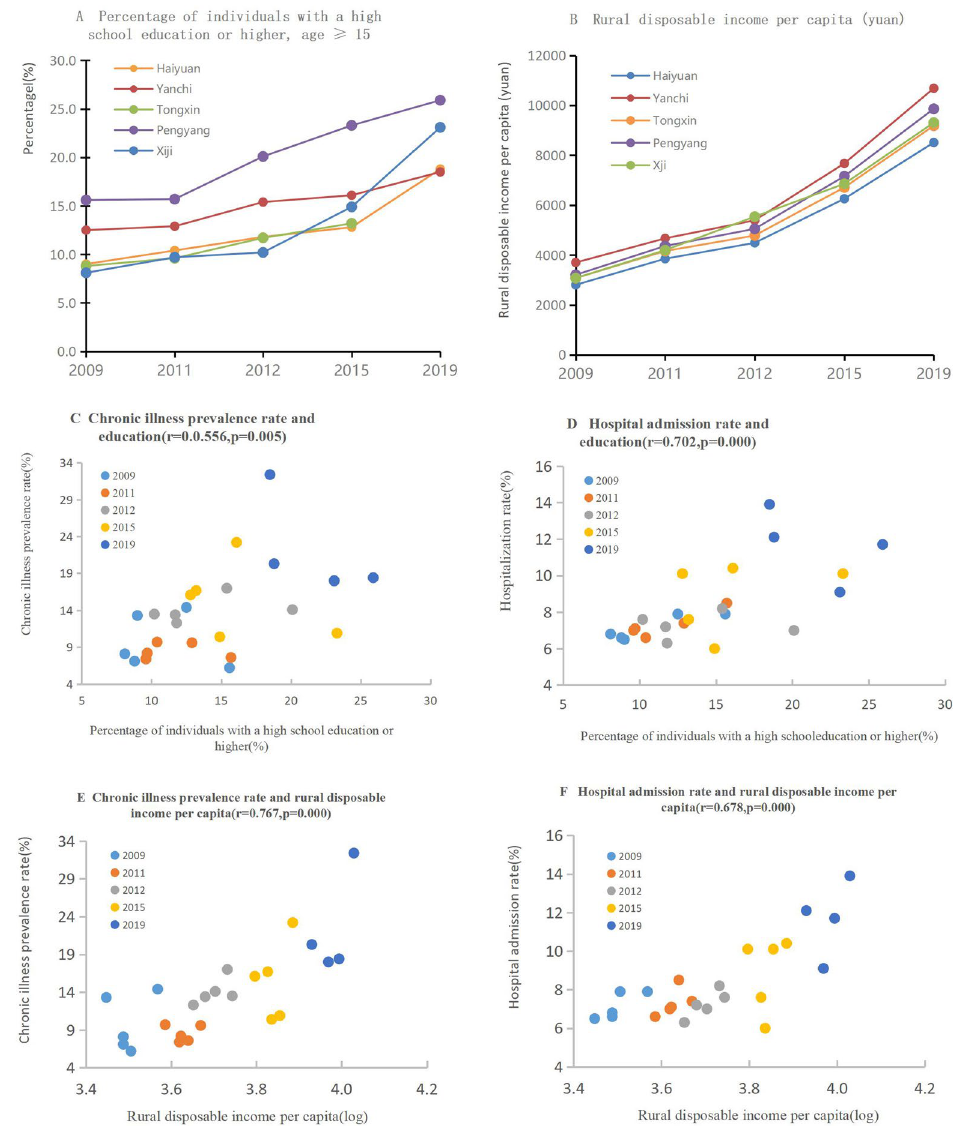
Figure 3. The associations between the chronic illness prevalence rate or the hospitalization rate and education levels or rural disposable income per capita.